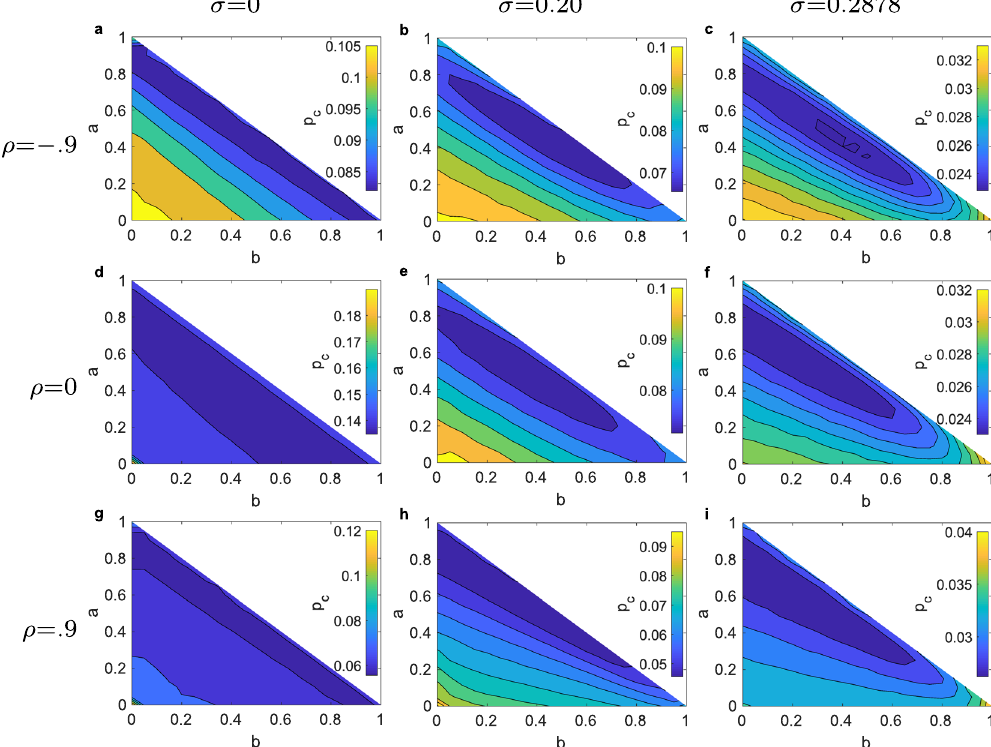
Figure 5. Contours of p c obtained by the BI selection strategy for reaching S eq = 0.5 by controlling parameters a and b (from Eq. (1), with a + b + c = 1) for graphs with N = 10,000, 〈 k 〉 = 10 and for ( a – c ) ρ = − 0.9, for ( d – f ) ρ = 0, for ( g – i ) ρ = 0.9, for ( a – g ) σ = 0, for ( b – h ) σ = 0.20, for ( c – i ) σ = 0.2887, with mean threshold φ = . 0 5 , for 500 repetitions, averaged for 500 different network realizations each with a different threshold generation. The resolution in the a and b weight space are